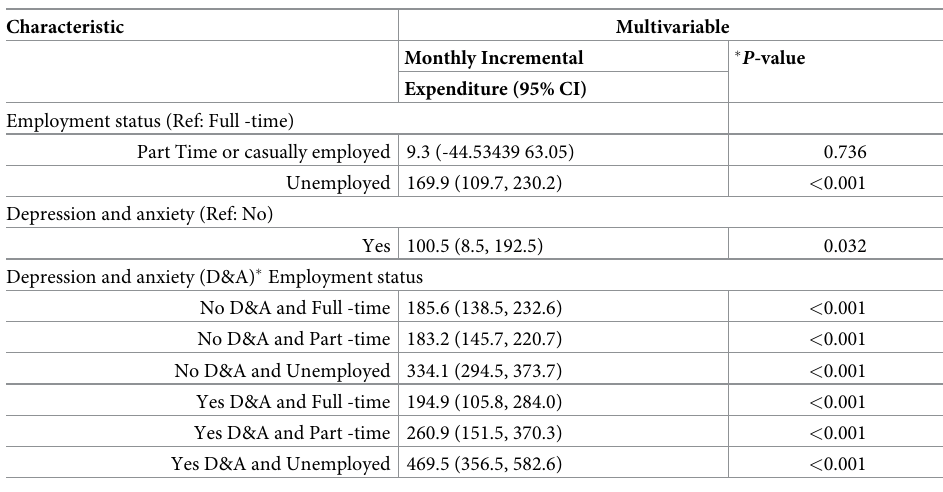
Table 6. Results from interaction